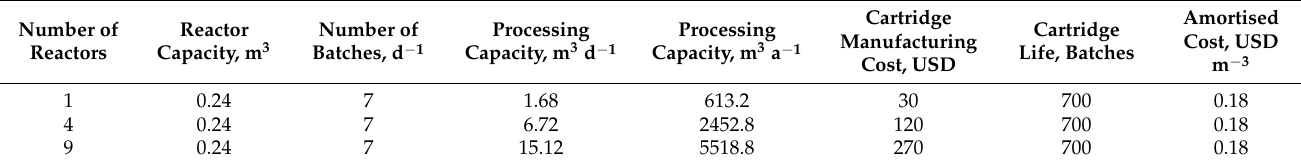
Table 4. n-ZVI cartridge scoping cost.